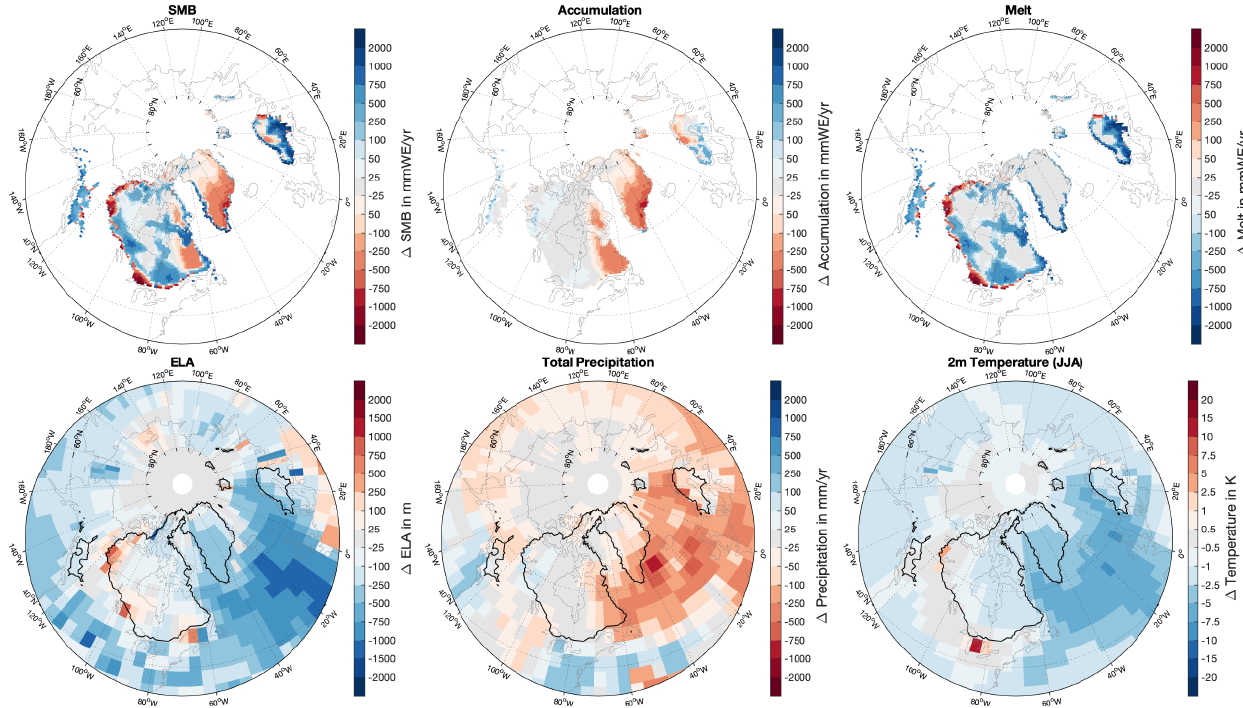
Figure 7. Similar to Fig. 5 but for differences between 11.6 and